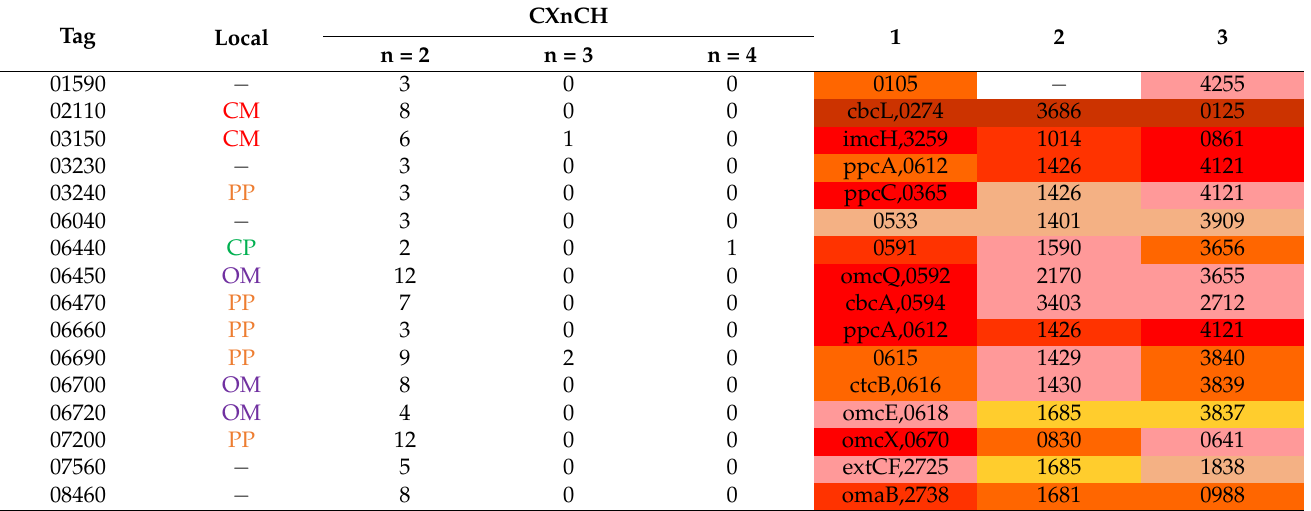
Table 3. List of putative c-type cytochrome proteins present in the NIT-SL11